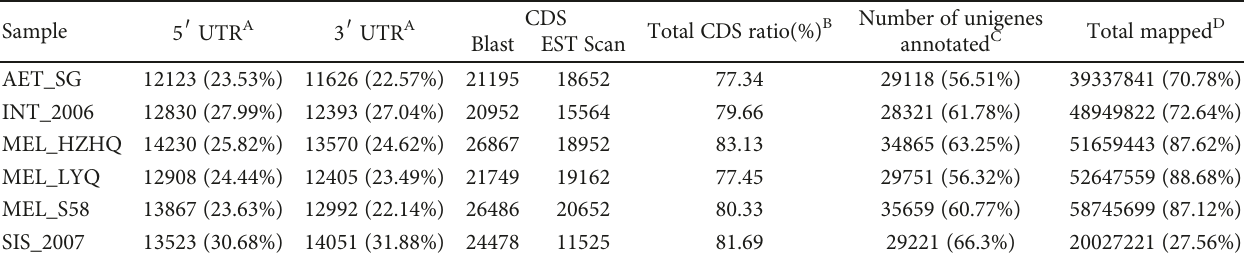
Table 3: The number and ratio of the CDS, annotated genes, and mapped sequences for the six eggplants.